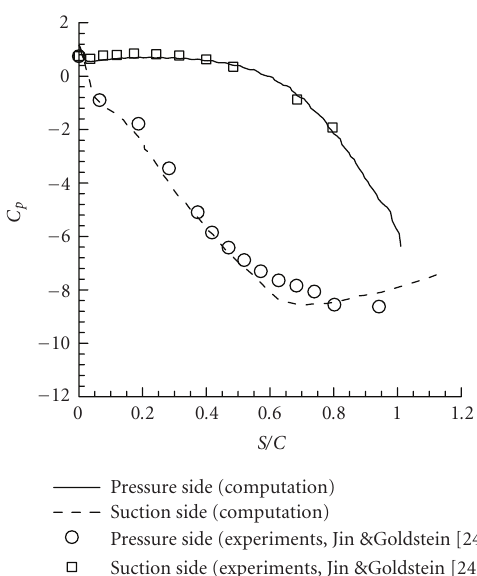
Figure 5: Comparison of pressure coe ffi cient on the blade surface with